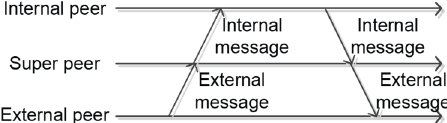
Figure 2. Messages in a free scale peer-to-peer network.